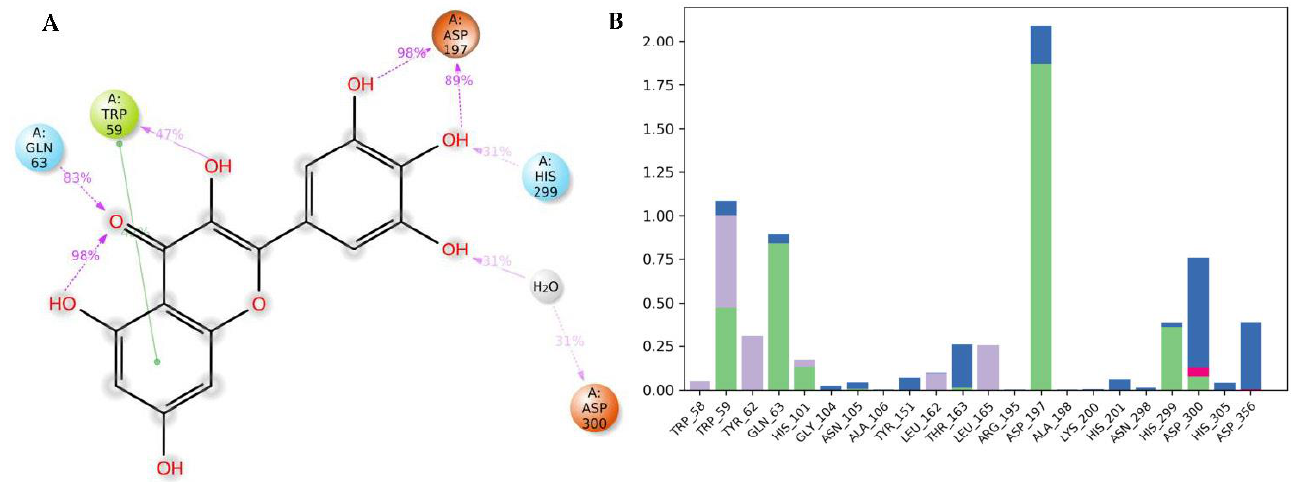
Figure 9. Analysis of molecular interactions and types of contacts with alpha-amylase after MD simulation. ( A ) Detailed schematic interaction of myricetin with the binding site residues of alpha- amylase in color scheme, where orange represents the charged, blue represents the polar, and light green represents the hydrophobic residues (PDB ID:4GQR). ( B ) Normalized stacked bar chart of alpha-amylase binding site residues interacting, with the native inhibitor showing the main types of bonding interaction: hydrogen bonds (green), hydrophobic (violet), ionic (red), and water bridges (blue).